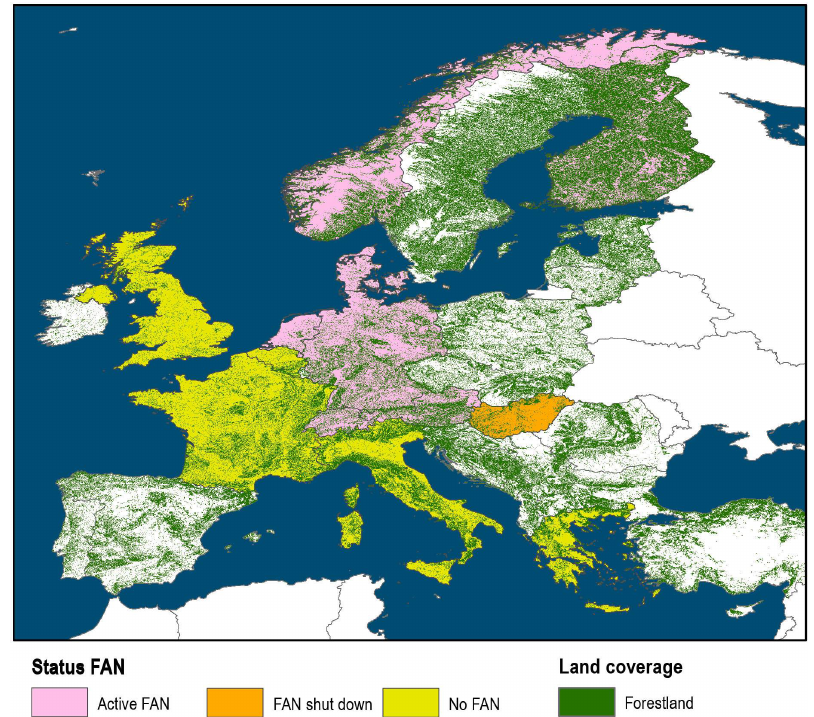
Figure 2. Matching information on forestland cover and the status of Forest Accountancy Data Networks (FANs). Forestland cover as classified by the European Environment Agency (EEA) forest land classification [27].